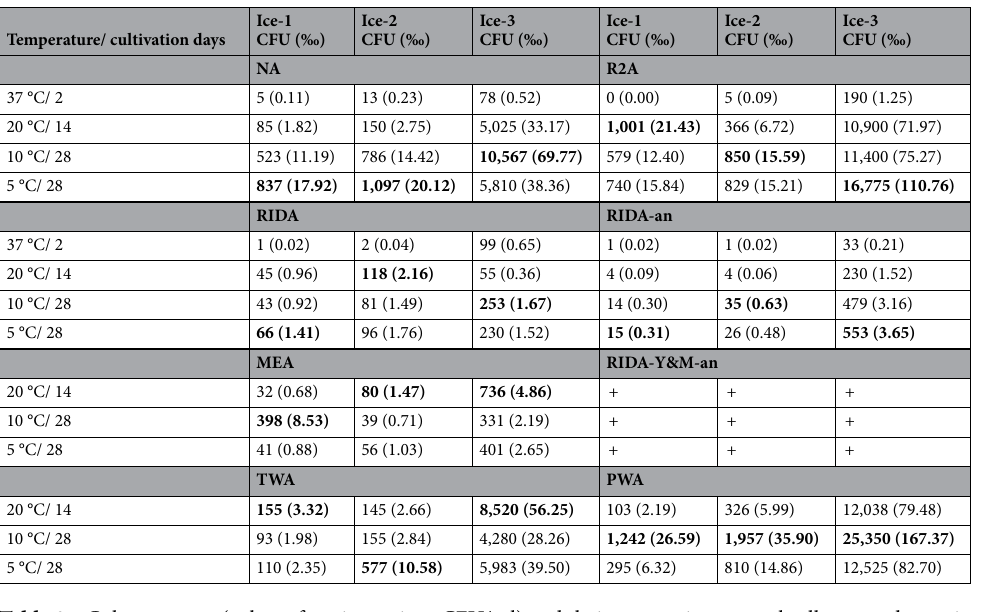
Table 2. Colony counts (colony-forming units—CFU/ml) and their proportion to total cell counts determined by flow cytometry (‰) at different cultivation conditions and media. In bold—highest value; RIDA RIDACOUNT total aerobic count; RIDA-Y&M RIDACOUNT yeast&mold rapid; an anaerobic, + presence, not